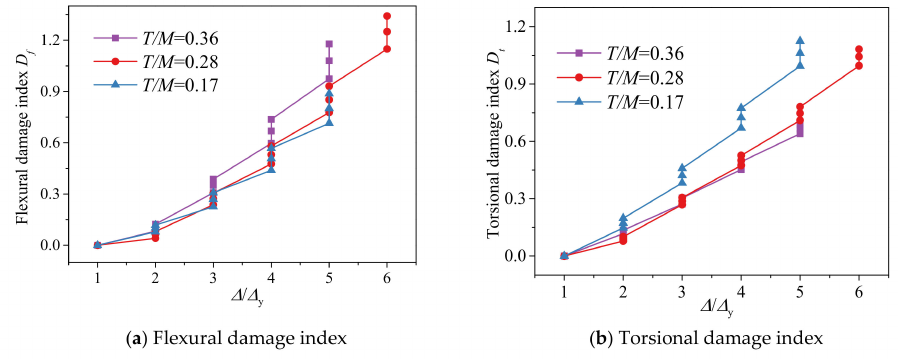
Figure 17. Influence of T / M ratio on the damage